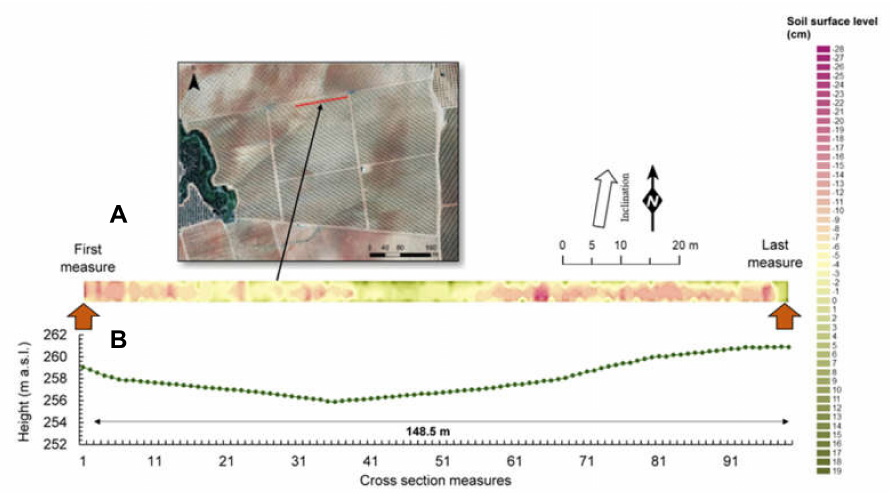
Figure 4. Improved Stock Unearthing Method (ISUM) map showing the soil surface level changes ( A ); longitudinal topographical changes ( B